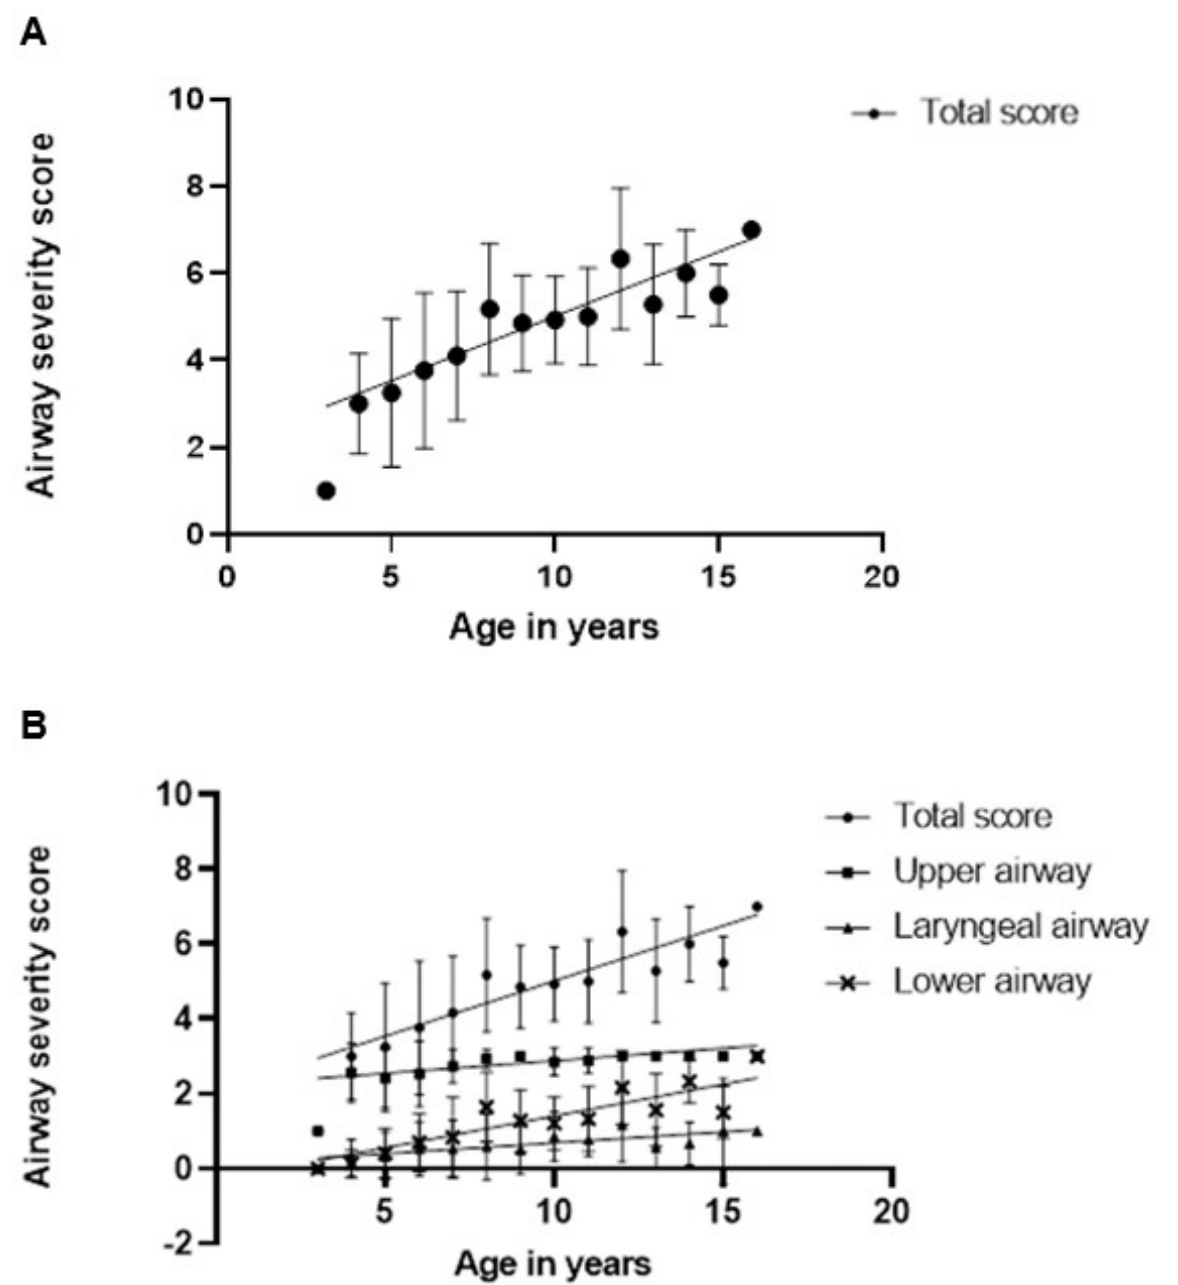
Figure 3. ( A ) Linear model fitted via generalized estimation equations (GEE) between average airway severity score and age. One year increase in age leads to an expected increase of 0.29 (95% CI: 0.2, 0.38; p < 0.0001) units in the airway severity score. ( B ) Linear model fitted via GEE between average severity score and age for each anatomic division used in the study. One year increase in age leads to an expected increase of 0.06 for upper airway (95% CI: 0.03, 0.09; p < 0.0001) 0.05 for laryngeal airway (95% CI: 0.01, 0.1; p < 0.0091) for lower airway 0.16 (0.11, 0.22; p < 0.0001) ( A , B ) Each point is the combined average airway severity score for bronchoscopies of subjects within this age group in increments of 1 year. Error bars represent standard deviation from the mean.